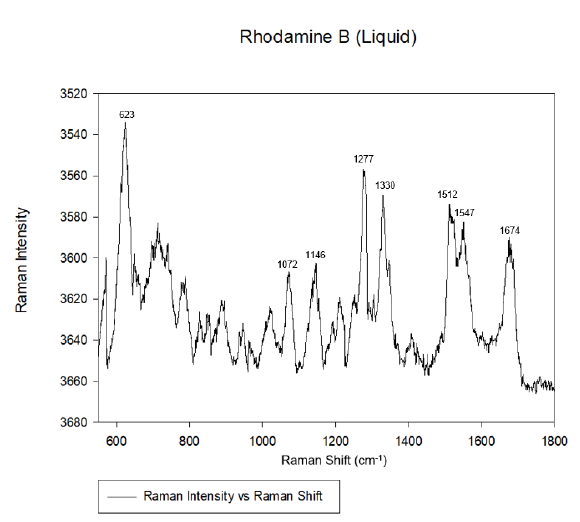
Fig. 8. Raman spectrum of Rhodamine B liquid